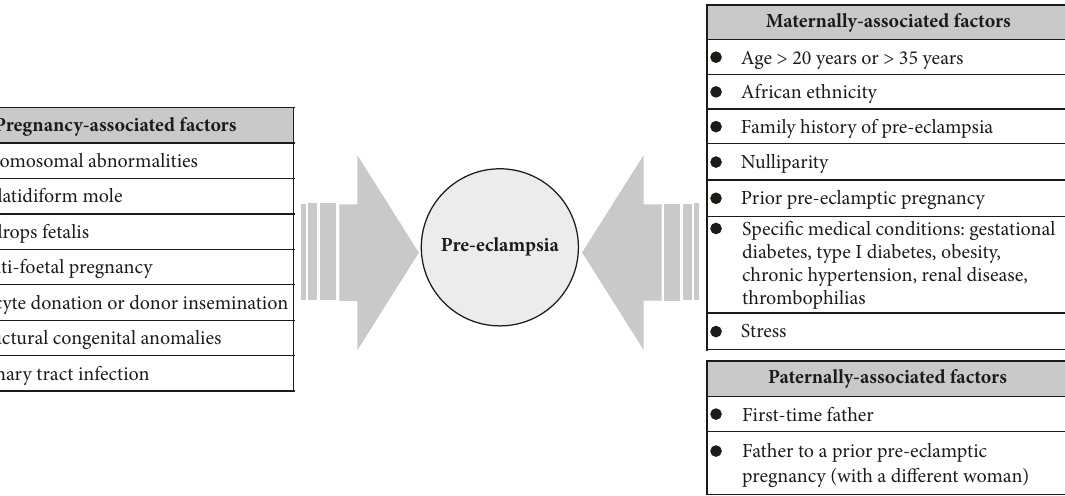
Figure 2: Risk factors for PE associated with the pregnancy itself or with specific parental characteristics from both maternal and paternal side [8,